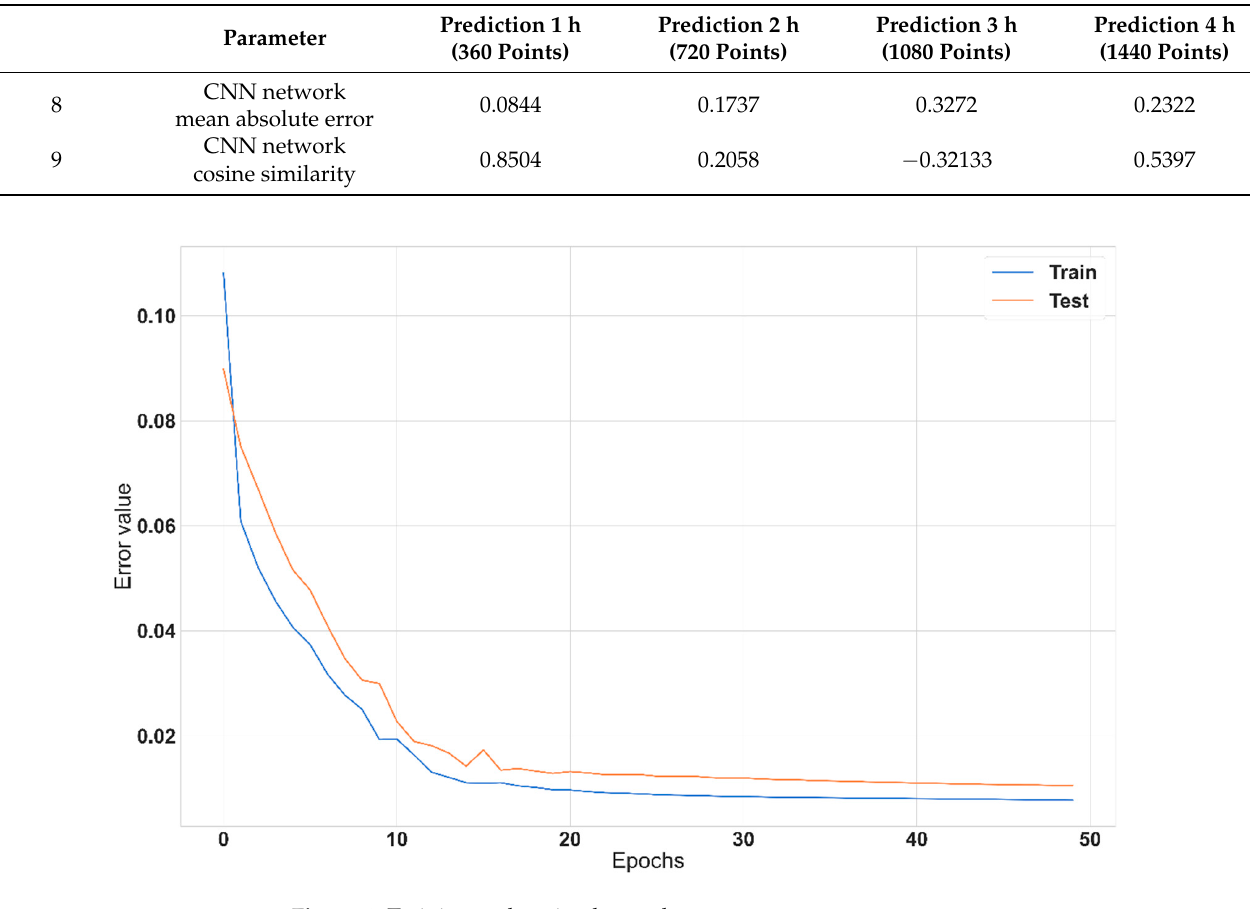
Figure 4. Training and testing loss-value error.